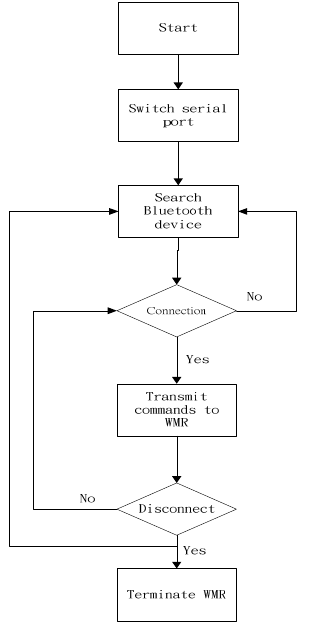
Figure 21. Sequence of smartphone operation.